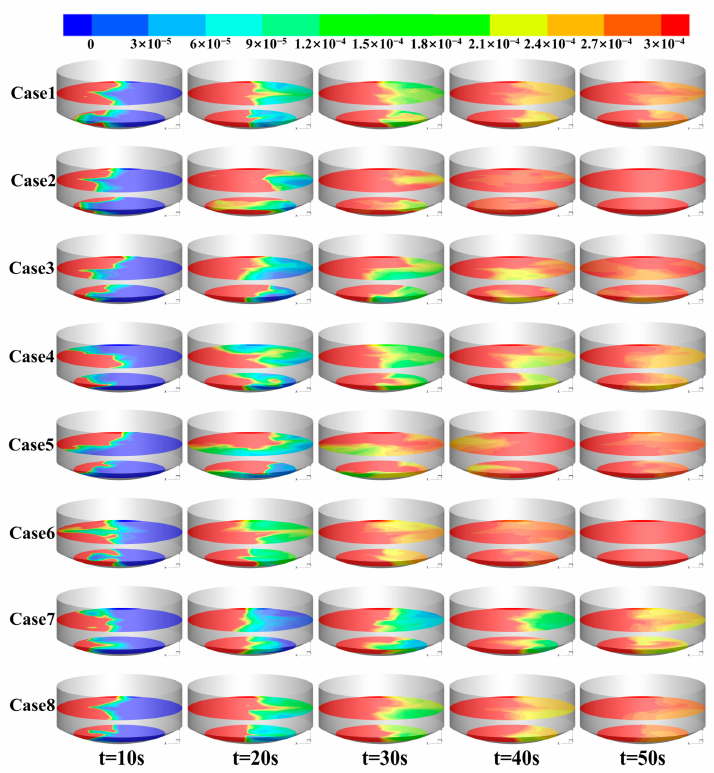
Figure 7. Distribution of the tracer concentration at 10 s, 20 s, 30 s, 40 s, and 50 s among the eight cases (bottom blowing